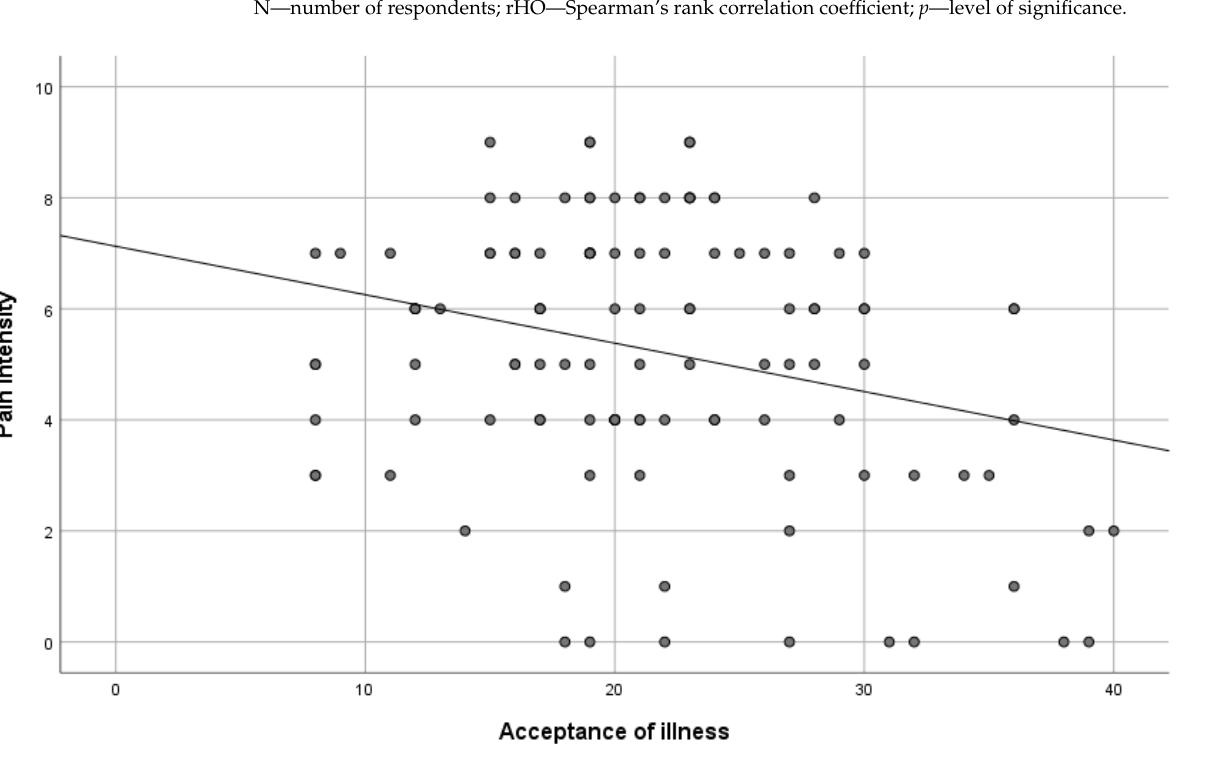
Table 11. Acceptance of illness versus disease-related symptoms.